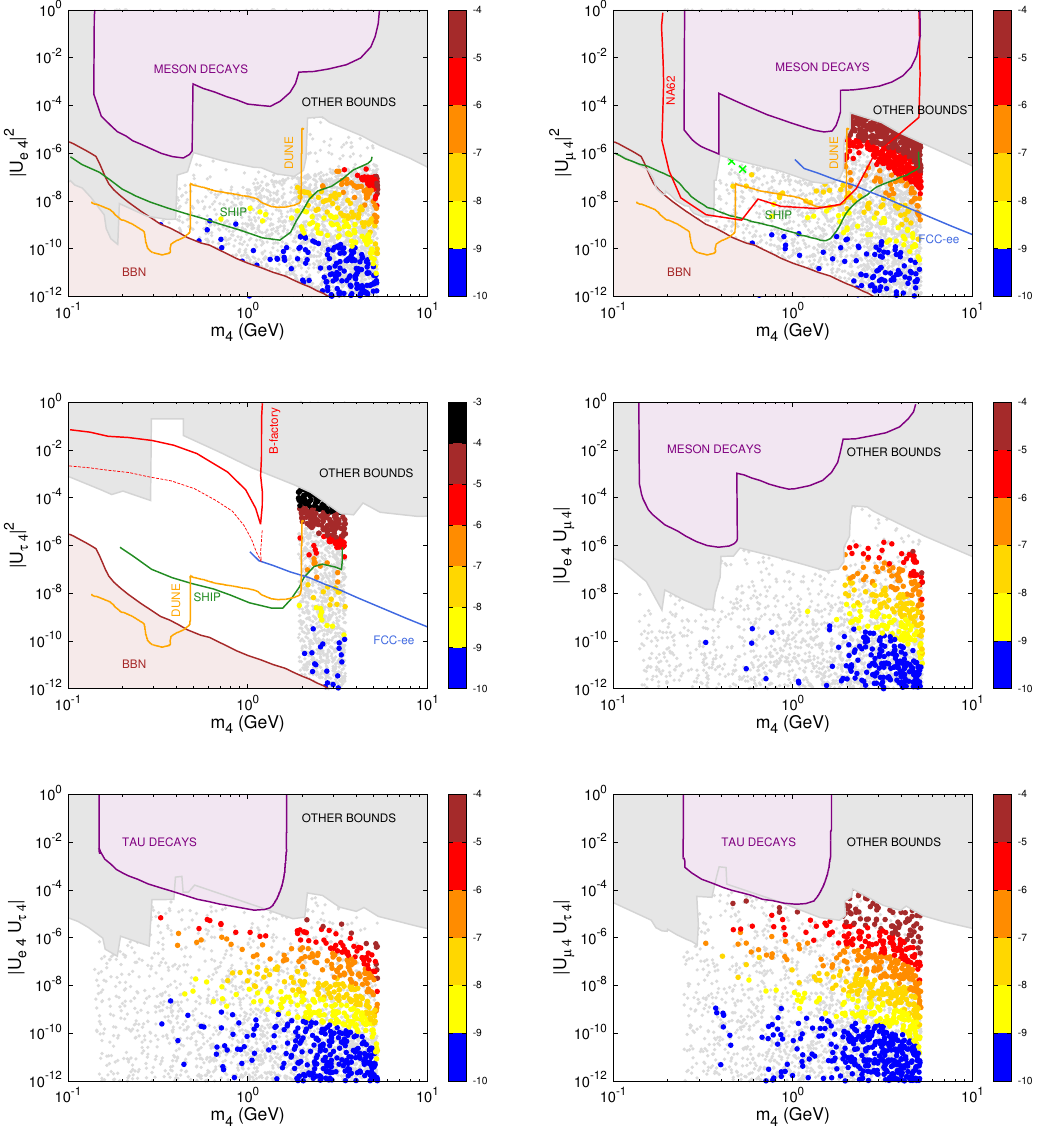
Figure 19 . Predictions for the e(cid:11)ective mass m (cid:11)(cid:12) in the sterile fermion parameter space (cid:23) ( j U ‘ U ‘ j ; m 4 ), as derived from the allowed values for the LNV decays B ! ‘ (cid:11) ‘ (cid:12) (cid:25) . The colour (cid:11) 4 (cid:12) 4 scheme of the in-laid points denotes regimes for the e(cid:11)ective mass, log( m (cid:11)(cid:12) ), in GeV; grey points (cid:23) denote exclusions due to the violation of experimental/observational bounds, as well as having an excessively long-lived sterile state. Solid surfaces (grey and pink) correspond to excluded regimes, and the solid lines denote the sensitivity of future experiments. Green crosses (present in the upper right panel) denote points which are excluded due to excessive contributions to LNV